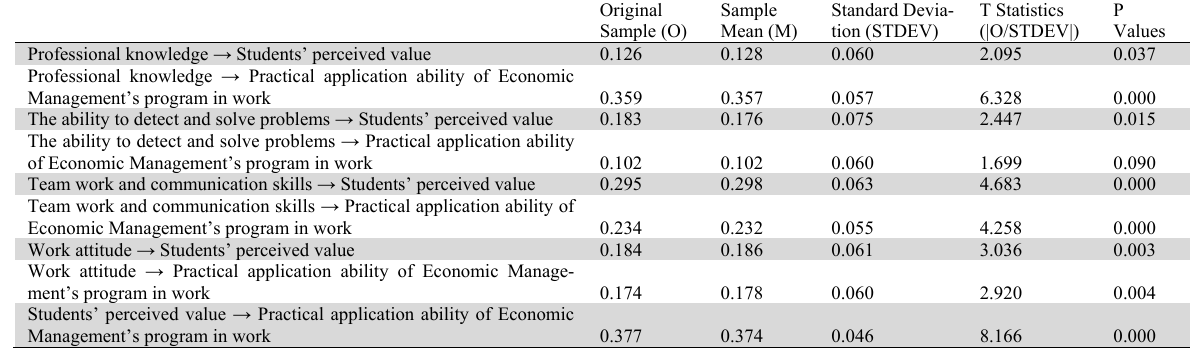
Bootstrapping results